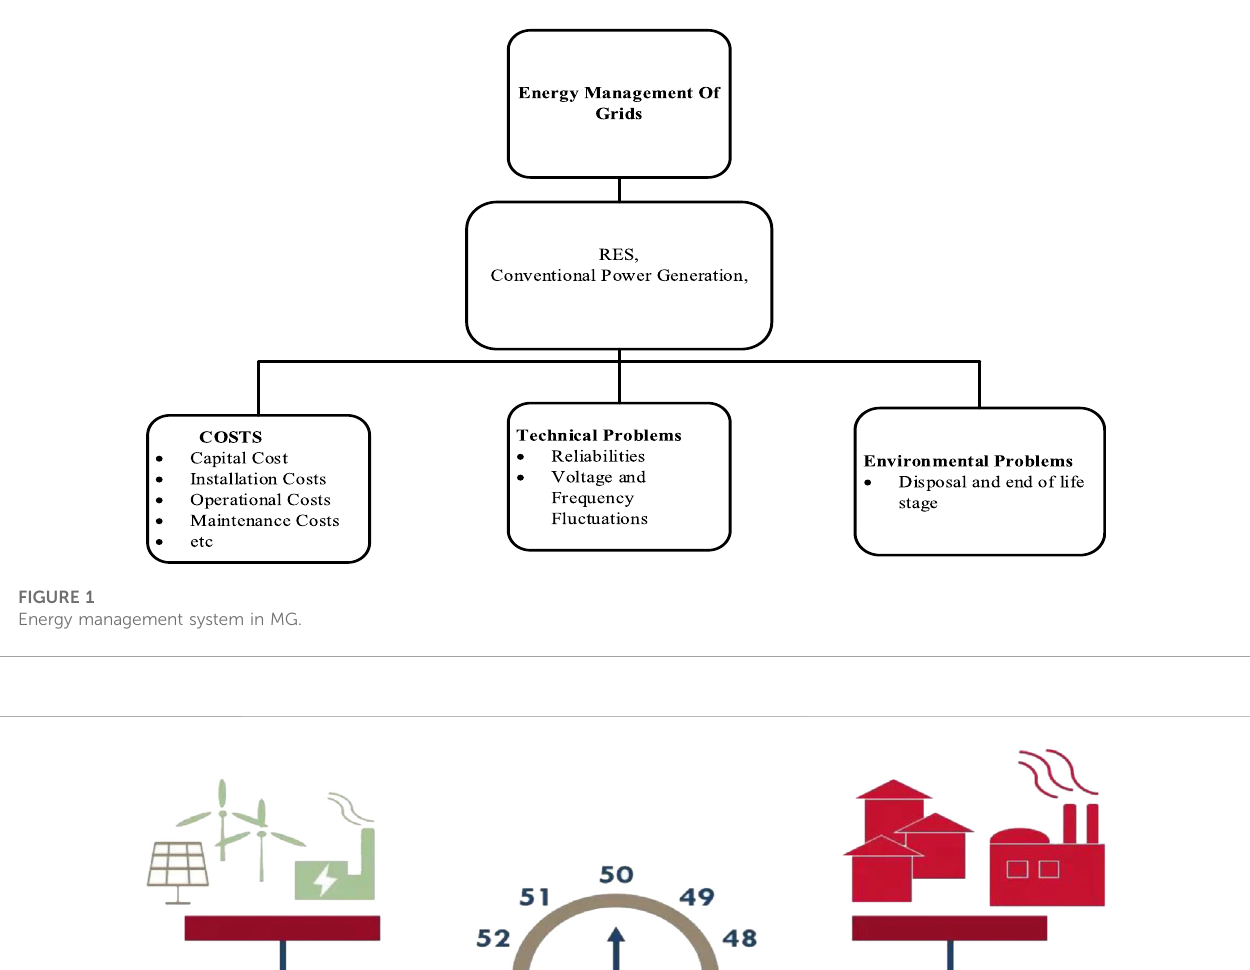
FIGURE 2 Demand and